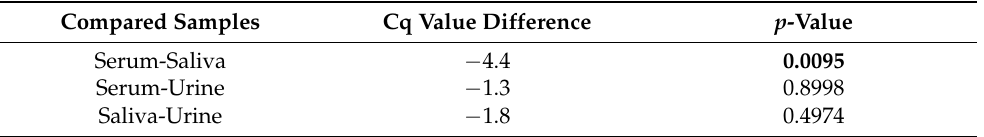
Table 2. Difference in the RT-qPCR signals observed between the serum, urine, and saliva samples. Cq value difference is based on the Cq value from the ZIKV (a) method indicated in Table 1 for each compared sample that were both presenting a positive signal (Cq value ≤ 38). p -value in bold is considered significant